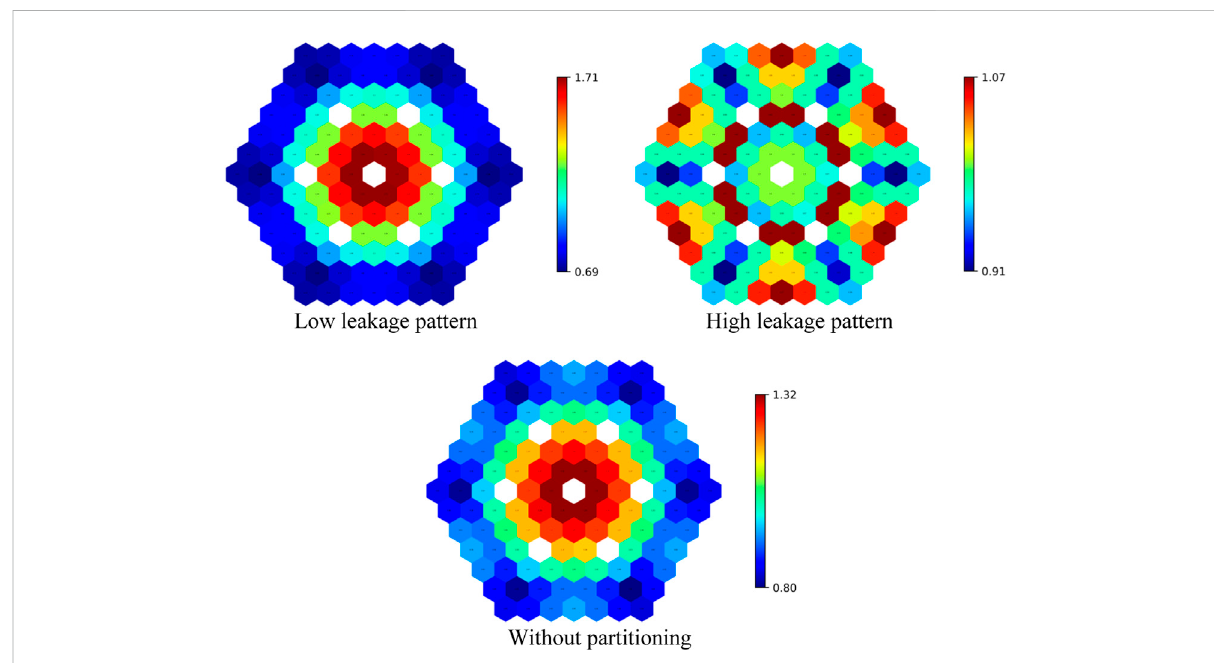
FIGURE 17 Assembly power distribution results on the beginning of life of the radial power fl attening